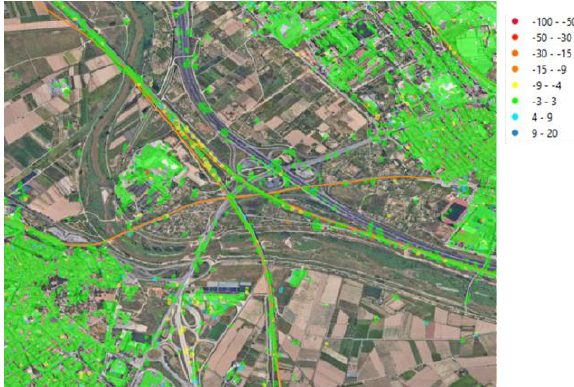
Figure 7 . An example of the displacement velocity map where points have not covered the railways in an east-west